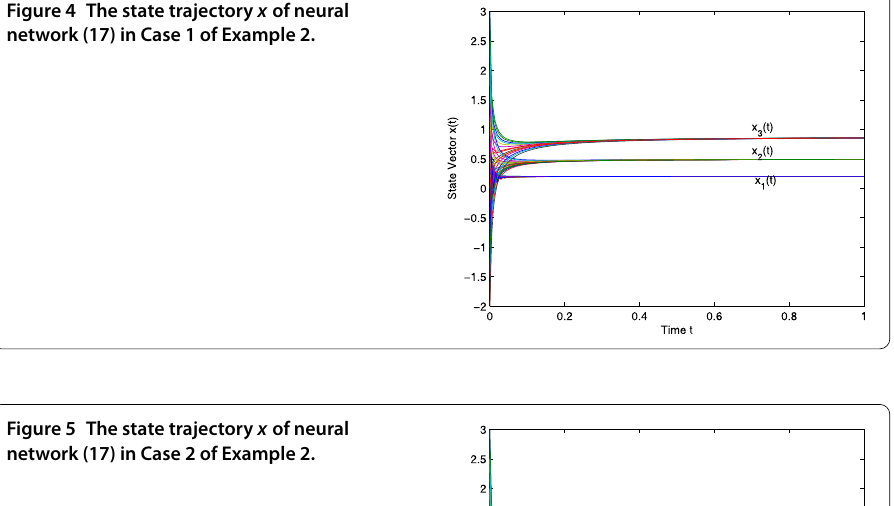
Figure 5 The state trajectory x of neural network (17) in Case 2 of Example 2.